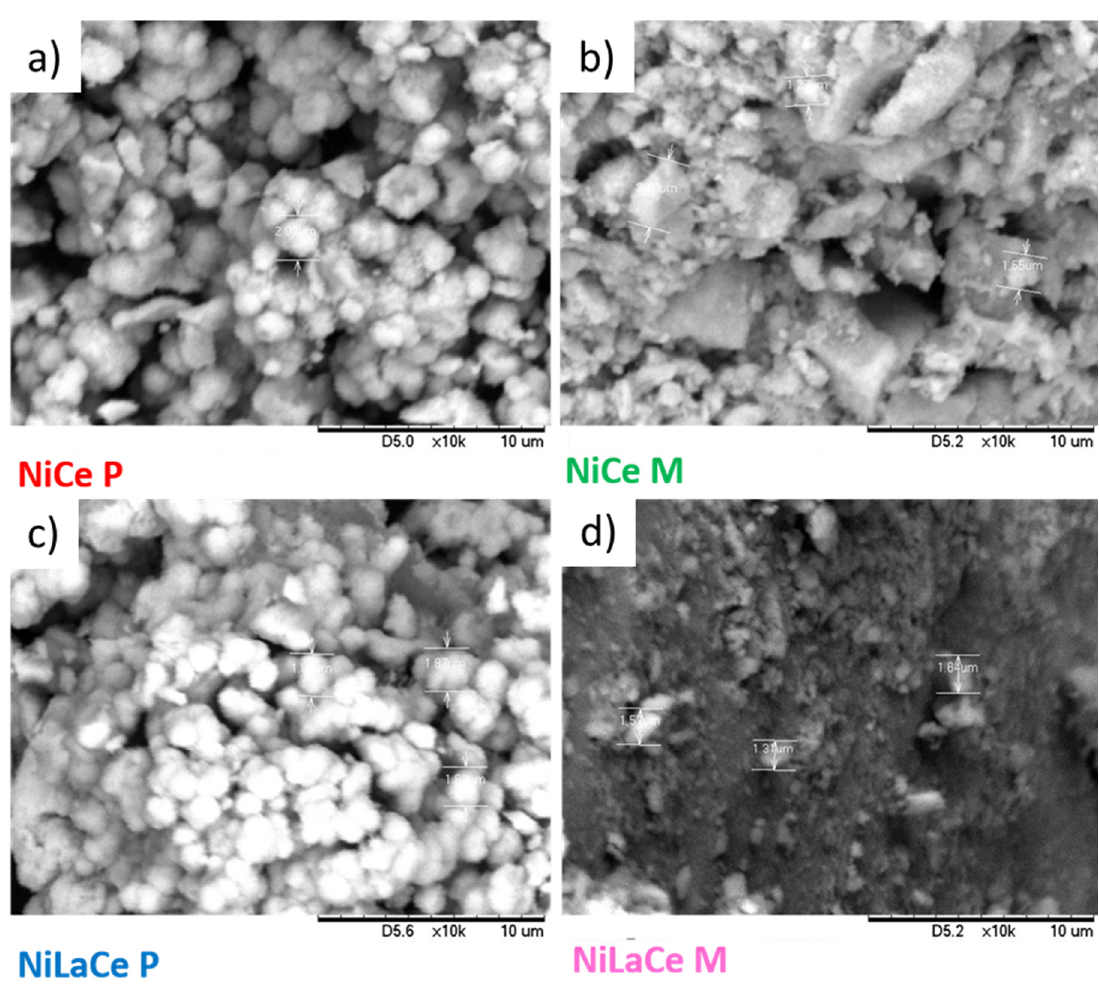
Processes 2021 , 9 , x FOR PEER REVIEW Figure 3. Representative SEM images of fresh catalysts ( a ) NiCe P, ( b ) NiCe M, ( c ) NiLaCe P and ( d ) NiLaCe M. XRD analyses using Scherrer refinement were carried out to determine the crystal size of the support and the metal phases in the samples. Figure 4 compares the XRD pat- terns of the four NiCe samples prepared via different support preparation methods.